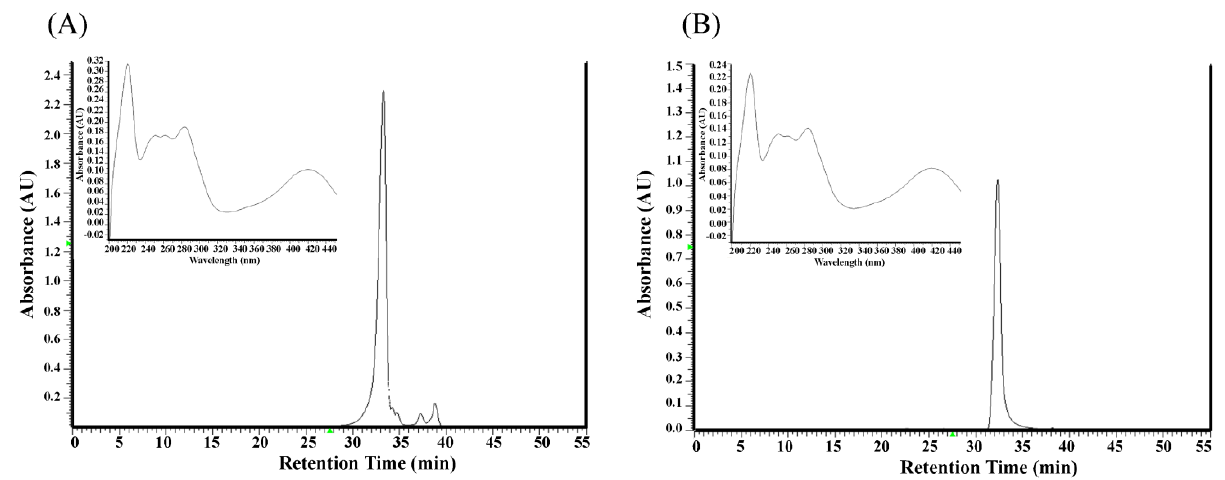
Figure 1. HPLC chromatograms and UV spectra of the ethylacetate subfraction F3 isolated from Polygonum cuspidatum root ( A ) and pure standard of emodin ( B ). Mobile phase: methanol–water (methanol: 0–15 min, 30%–50%; 15–35 min, 50%–90%; 35–45 min, 95%); flow rate: 1.0 mL/min; detection wavelength: 280